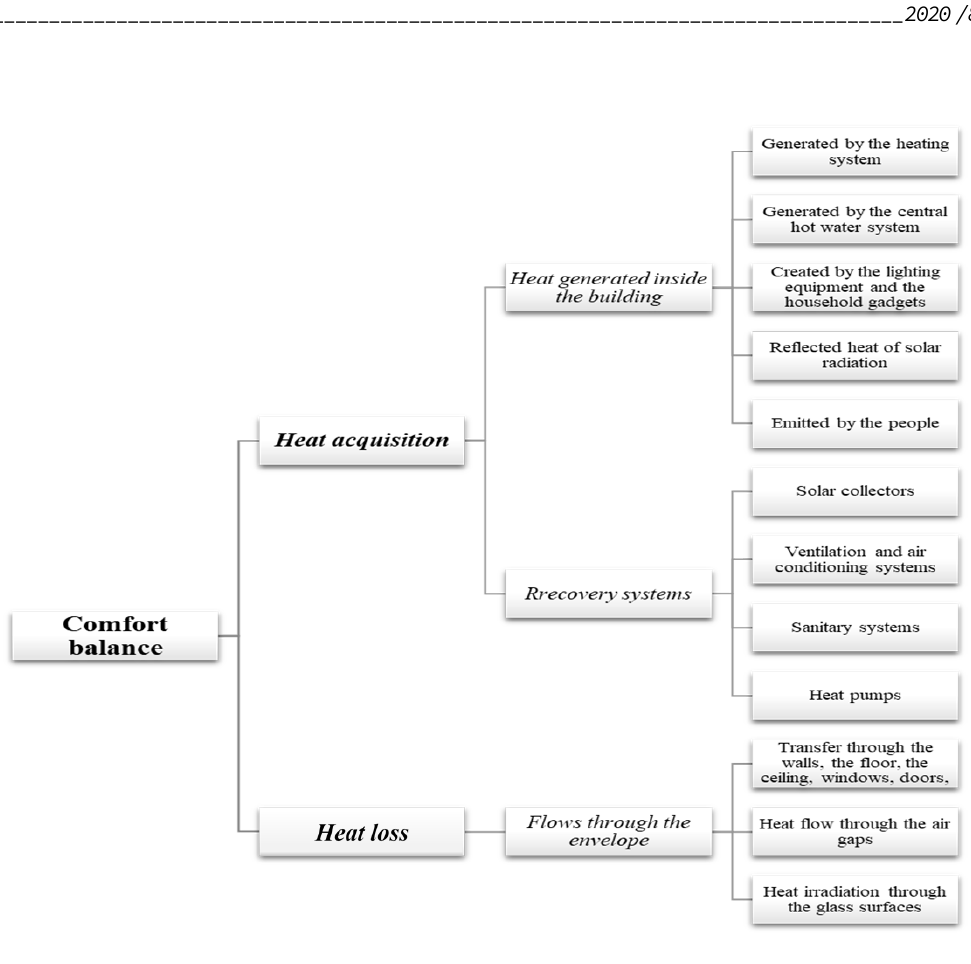
Fig. 2. The energy equilibrium components (Actiņa & Geipele,